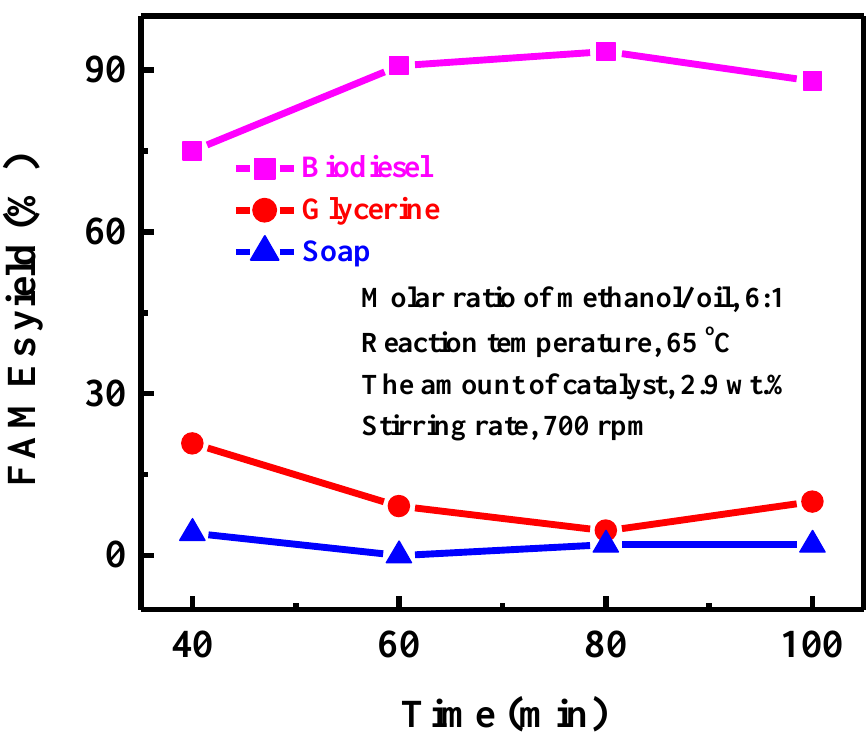
Figure 7. The e ff ect of reaction time on RTOB Figure 7. The effect of reaction time on RTOB yield.